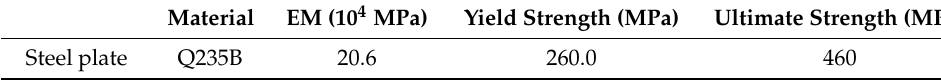
Table 4. Characteristics of steel plates.